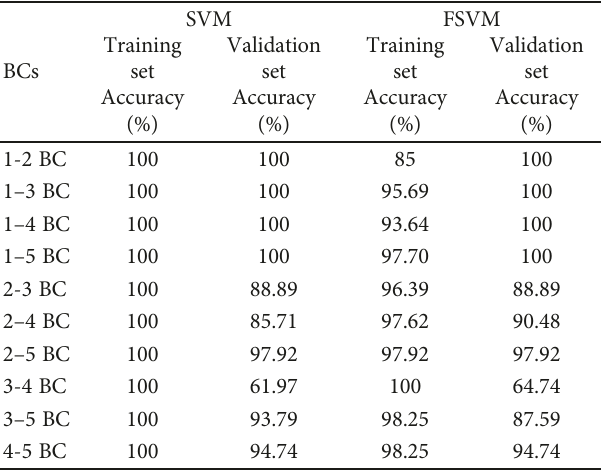
Table 14: Prediction results of RTE with group